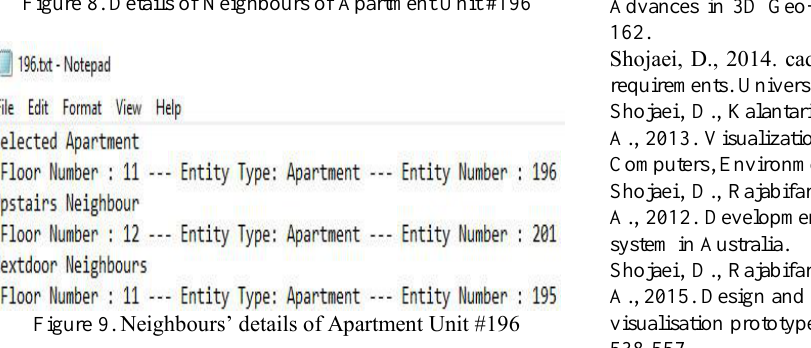
Figure 7a. identifying input apartment unit.